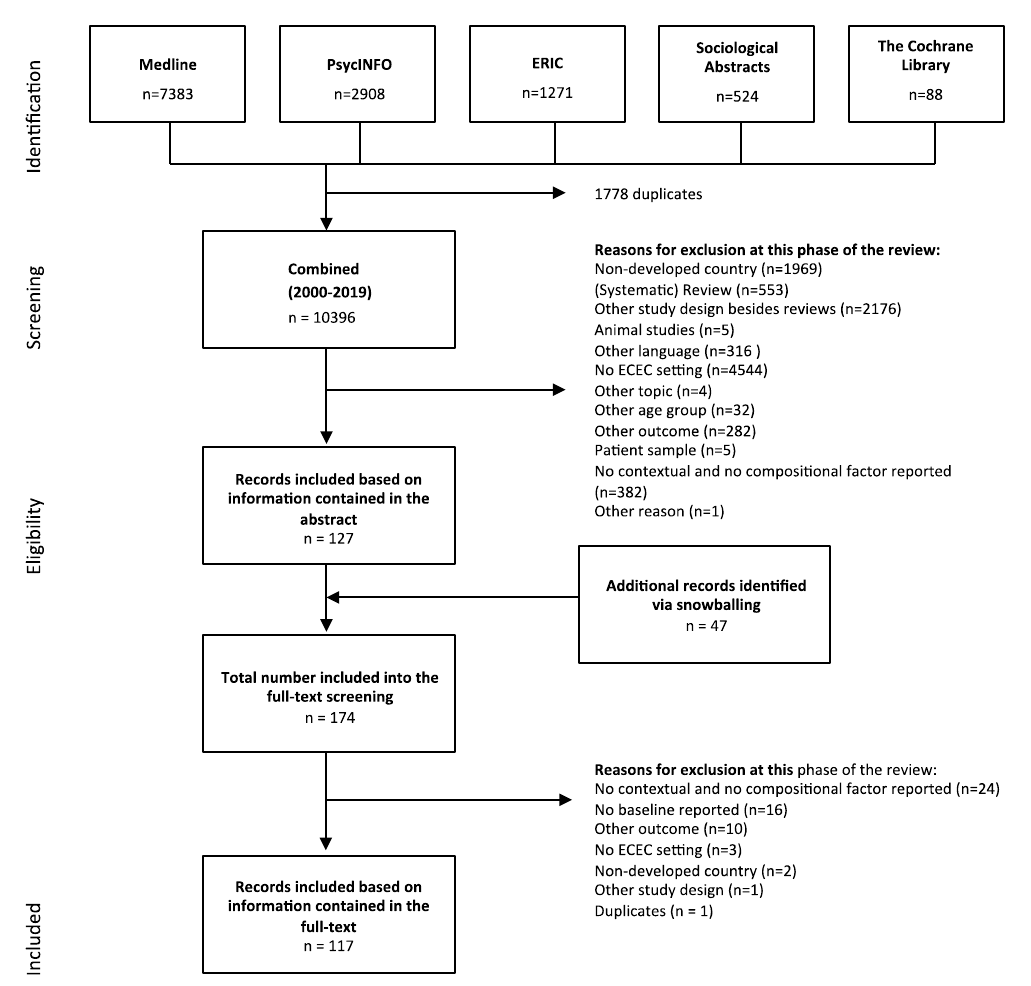
Figure 1. PRISMA flow diagram (according to the recommendations of Moher et al. 2009 for reporting reviews [15]).